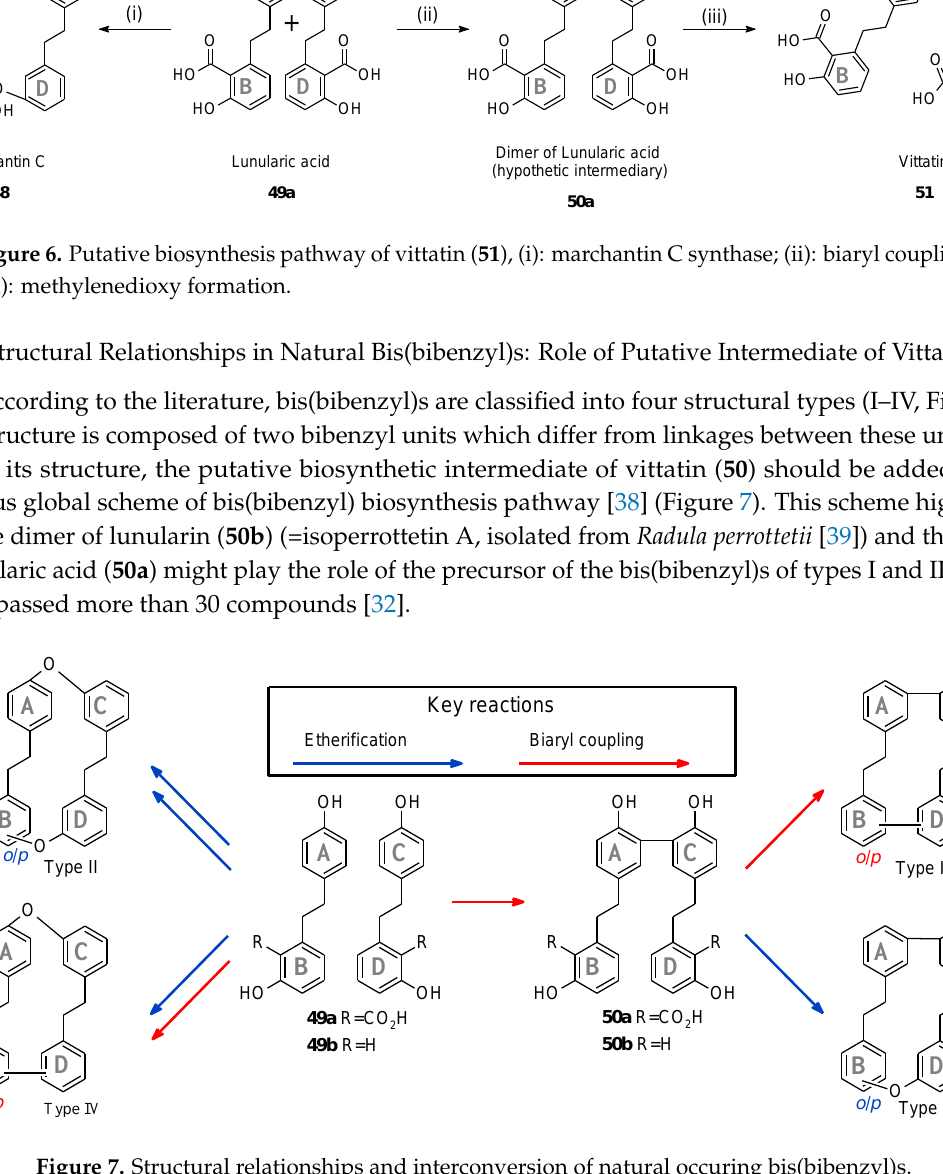
( b ) Figure 5. ( a ) HMBC (blue arrows) key correlations of compound ( 51 ); ( b ) COSY (bold) and selected NOE (red arrows) correlations of compound ( 51 ). 2.6.2. Putative Biosynthesis of Vittatin ( 51 ) Bis(bibenzyl)s are biosynthesized from lunularin ( 49b ) or its precursor lunularic acid ( 49a ). This assumption was supported by feeding experiments using radioactive and 13 C-labelled precursors [34]. Marchantin C synthase (isolated from a cell culture of Marchantia polymorpha ) was supposed to be involved in the coupling mechanism of two molecules of lunularic acid ( 49a ) leading to marchantin C ( 48 ) (type II) [35]. Due to the functionalization of vittatin ( 51 ), hypothesis can be proposed suggesting that this